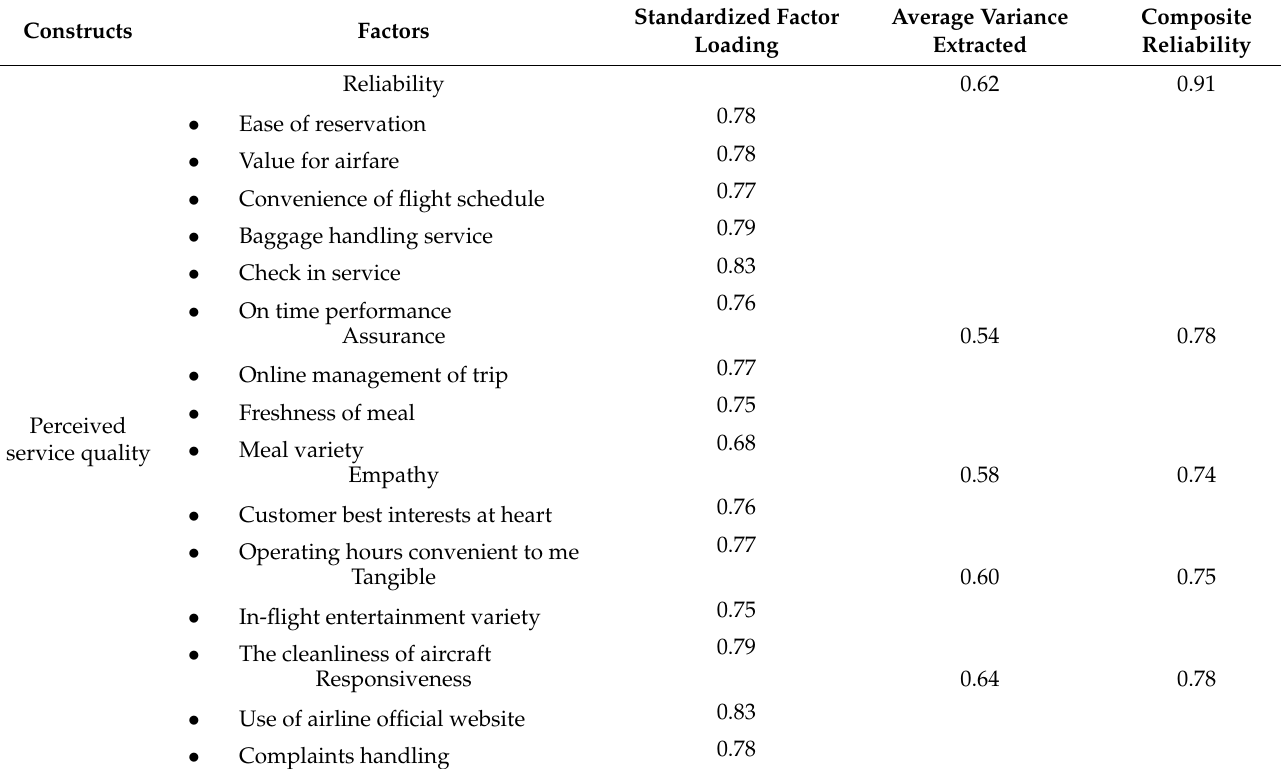
Table 2. Confirmatory factor analysis of different constructs of the